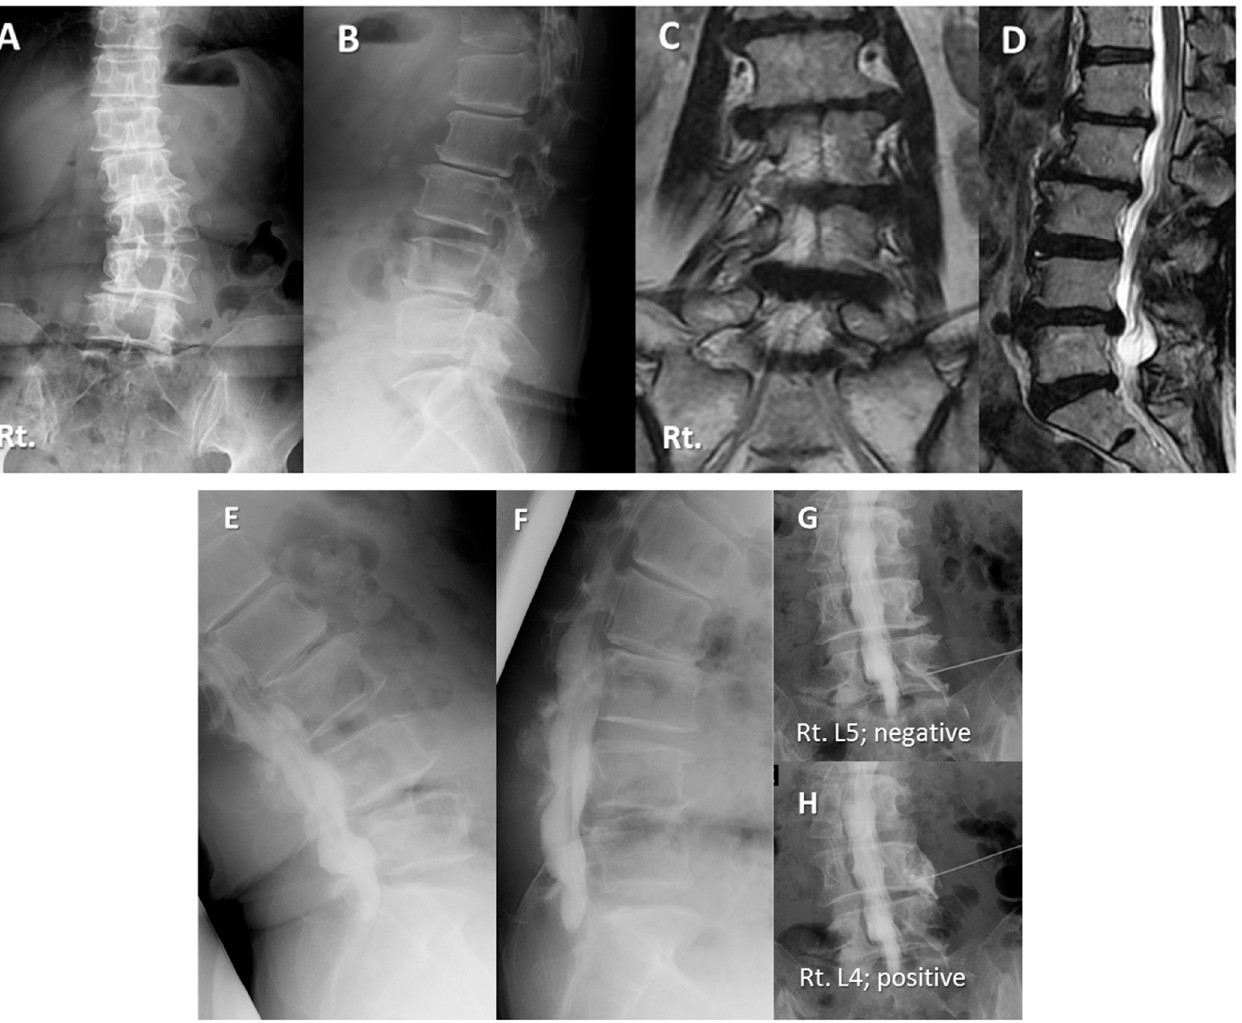
Figure 4. Seventy-two-year-old woman with lumbar degenerative scoliosis and multiply operated back: ( A , B ) Preoperative lateral radiographs showing lumbar degenerative scoliosis with postoperative state of L2/3/4/5 posterior decompression surgery. ( C , D ) Magnetic resonance imaging showed foraminal stenosis due to scoliosis. ( E , F ) Preoperative myelogram of functional lateral findings showing lumbar instability without spinal central canal stenosis. ( G ) Although she suffered from right (Rt.) leg pain and numbness at the L5 dermatome, causing significant disability of daily living and gait disturbance, the Rt. L5 nerve block was ineffective. ( H ) Rt. L4 nerve block was effective but transient.